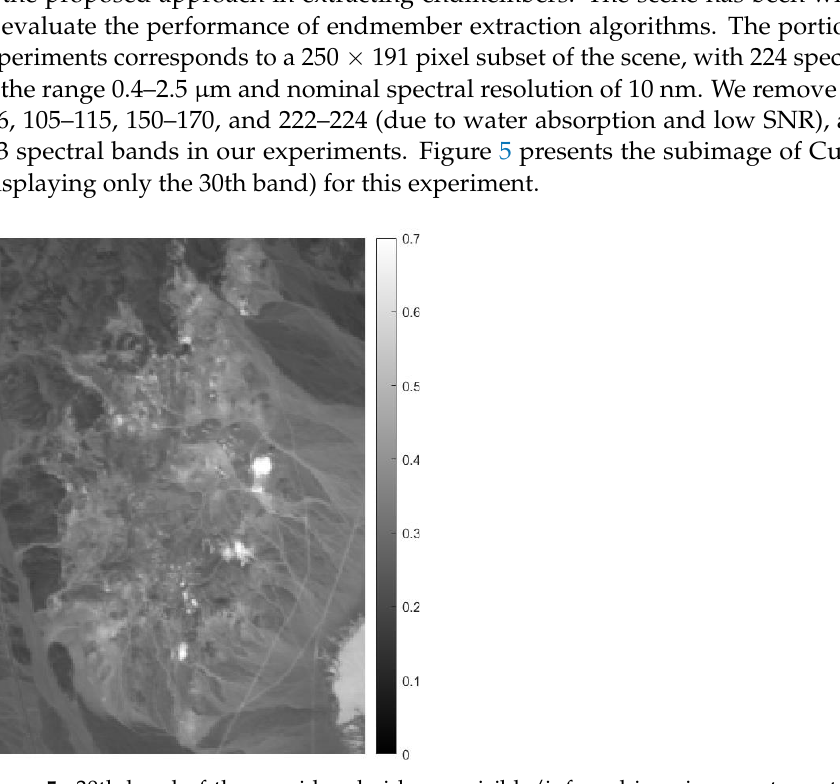
Figure 5. 30th band of the considered airborne visible/infrared imaging spectrometer (AVIRIS) Cuprite subimage.